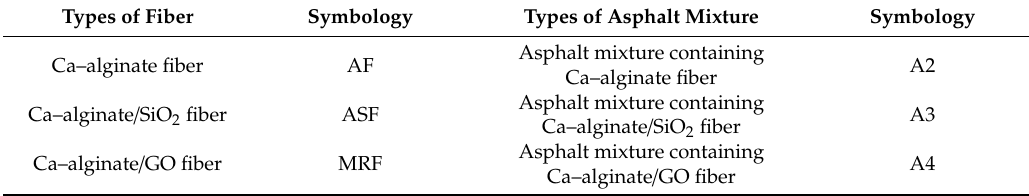
Table 2. Types symbology of fibers and asphalt